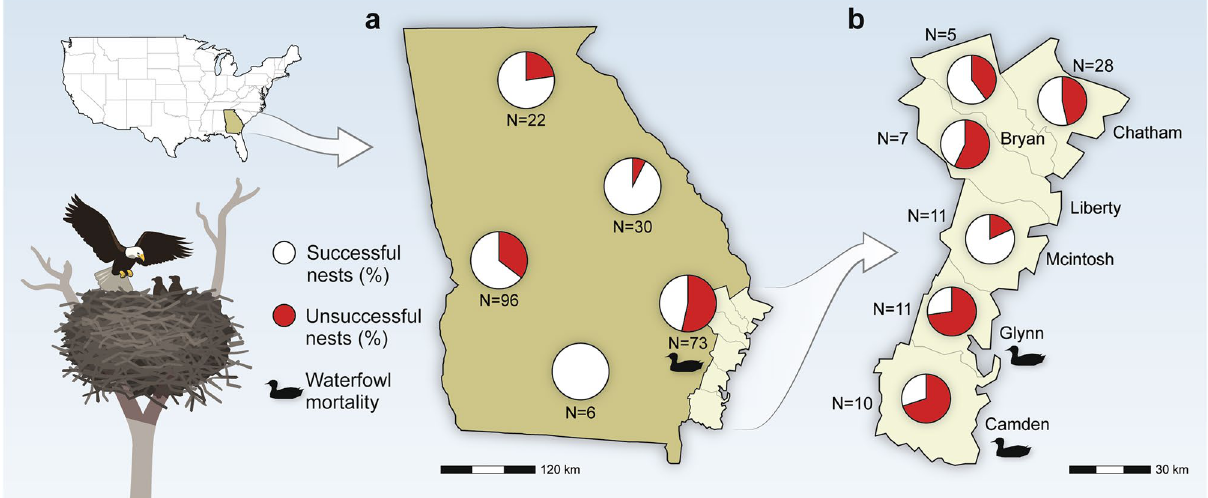
Figure 3. Reproductive indices for nesting bald eagles in Georgia, USA in 2022. ( a ) Regional bald eagle percent nest success in Georgia during 2022. ( b ) Bald eagle nest success in Atlantic coastal counties of Georgia during 2022. Aerial nest surveys are performed annually during March by the Georgia Department of Natural Resources. N = number of occupied nest territories surveyed.